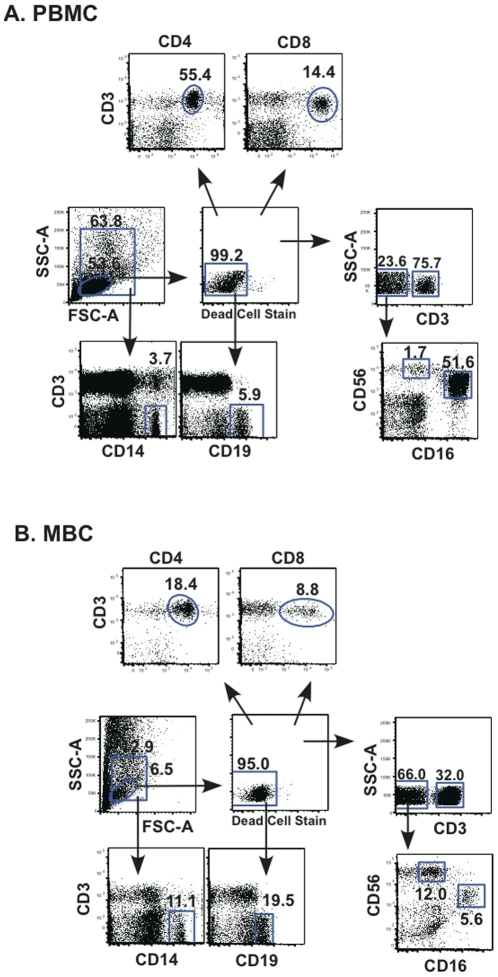
Gating strategy for menstrual and peripheral blood cells.
A. PBMC and B. MBC. Initial gating is performed from the SSC-A vs. FSC-A to determine the total lymphocyte gate (small gate) and the larger gate is used to further gate for monocytes (CD14). From the lymphocytes, live cells are gated, followed by gating B cells (CD19), T cells (CD3), CD4+CD3+ and CD8+CD3+ cells. From the CD3- gate, NK cell phenotypes are selected. CD16-CD56+(immunoregulatory cells) and CD16+CD56+(Cytotoxic cells). Percentages of positive cells for a given marker are indicated above/near gate.